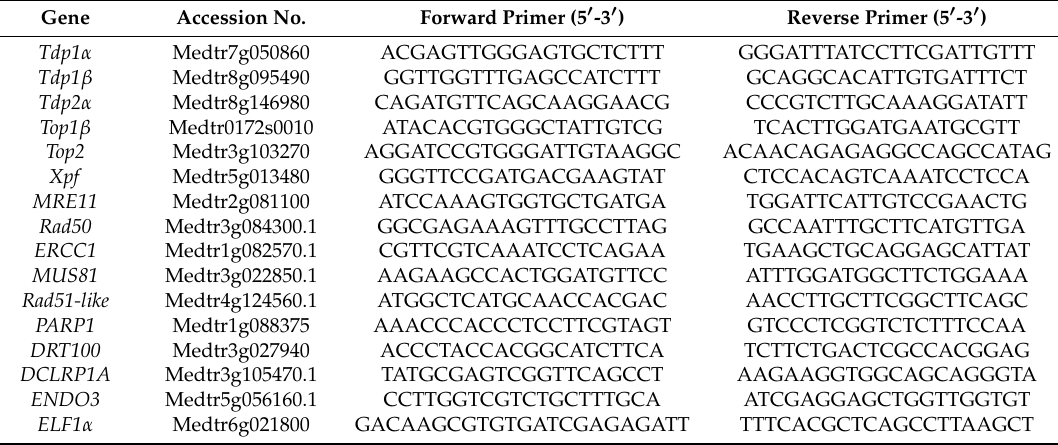
Table 1. Sequences of oligonucleotide primers used in the quantitative real-time polymerase chain reaction (qRT-PCR). Phytozome accession identifiers are provided.